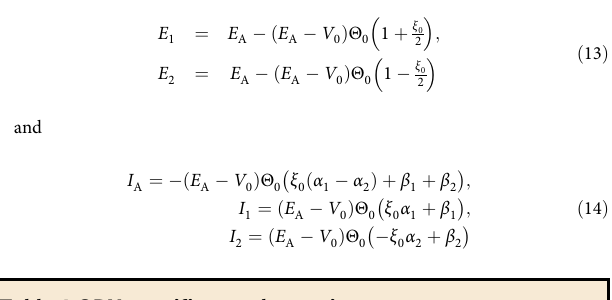
Table 1 ORN-speci fi c morphometric parameters ORN type